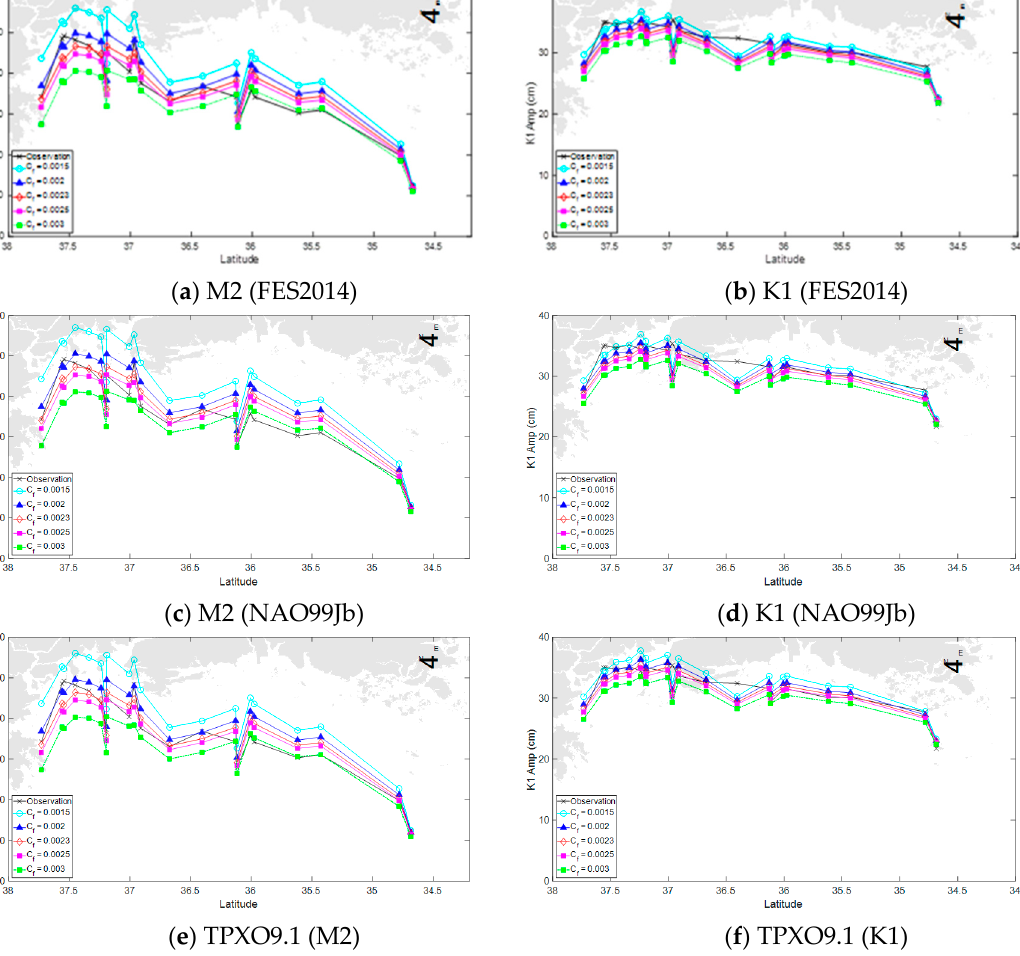
Figure 8. The numerical results of tidal amplitudes M2 and K1 obtained from different uniform bottom roughness; ( a ), ( c ) and ( e ): M2’s amplitude; ( b ), ( d ) and ( f ): K1’s amplitude.